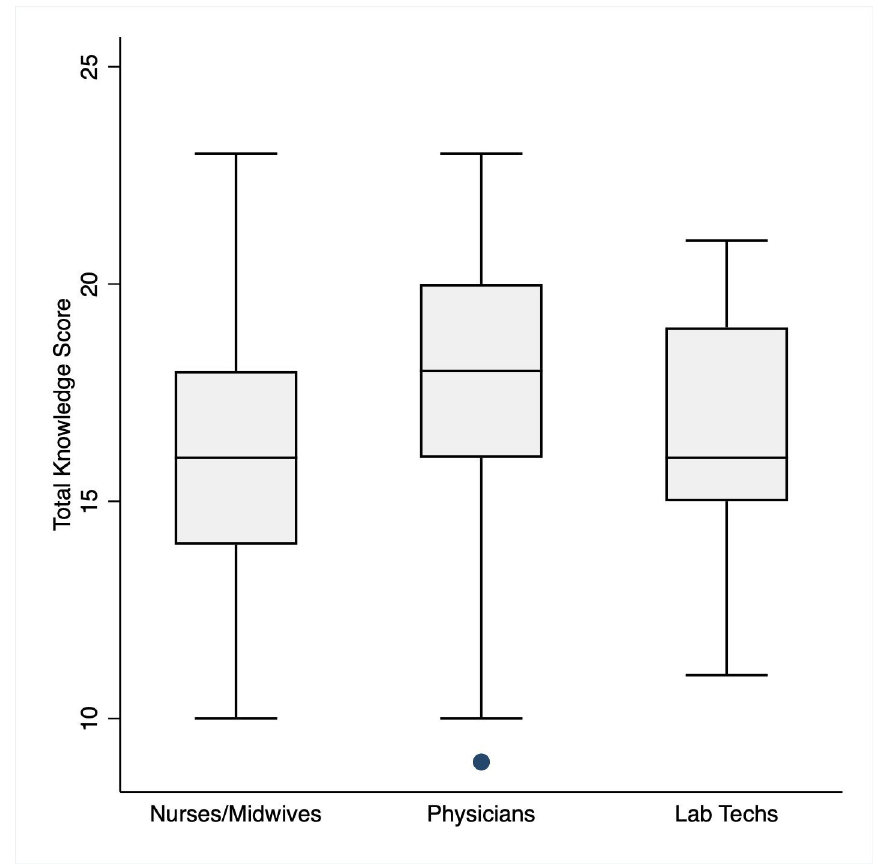
Fig 1. Knowledge scores by professional category. Mean knowledge scores amongst nurses/midwives (16.2 ± 2.6), physicians (17.6 ± 3.2), and laboratory technicians (16.3 ± 2.7) at Jimma University Medical Center (p-value 0.002).